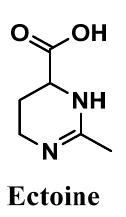
Figure 11. Chemical structure of